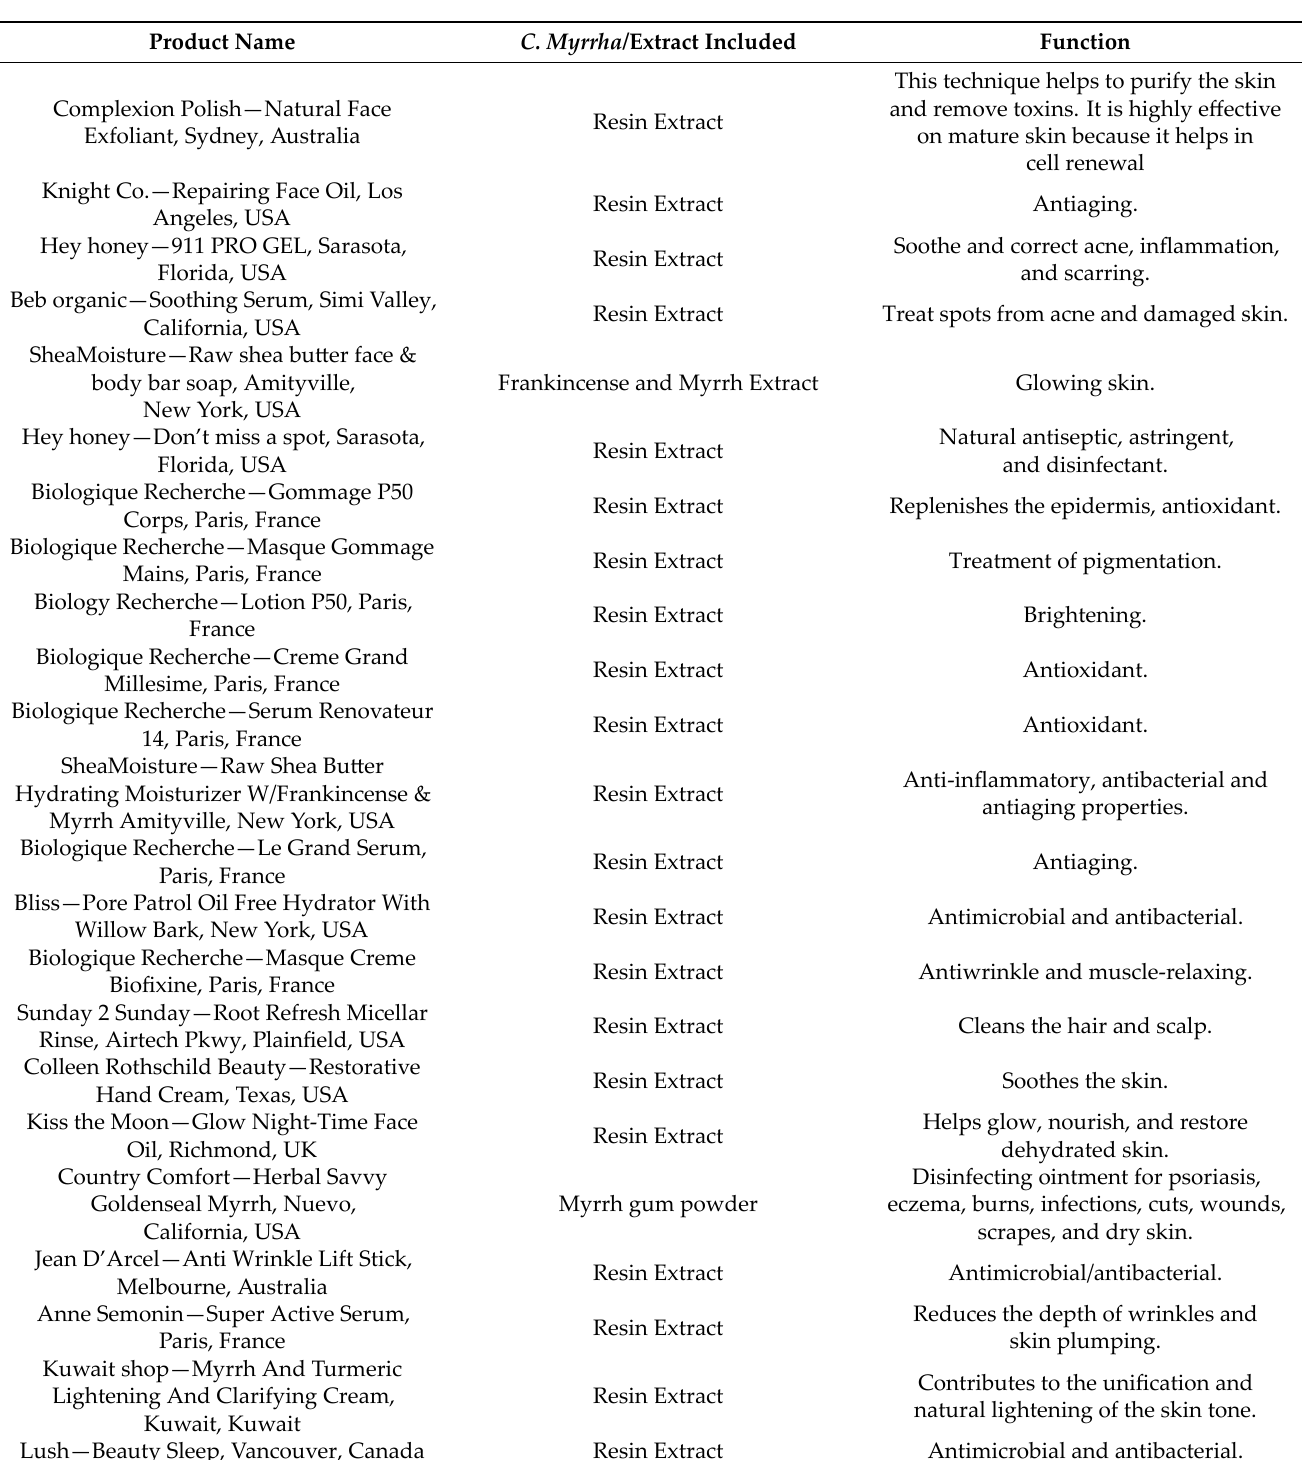
Table 2. Cosmetic products containing C. Myrrha